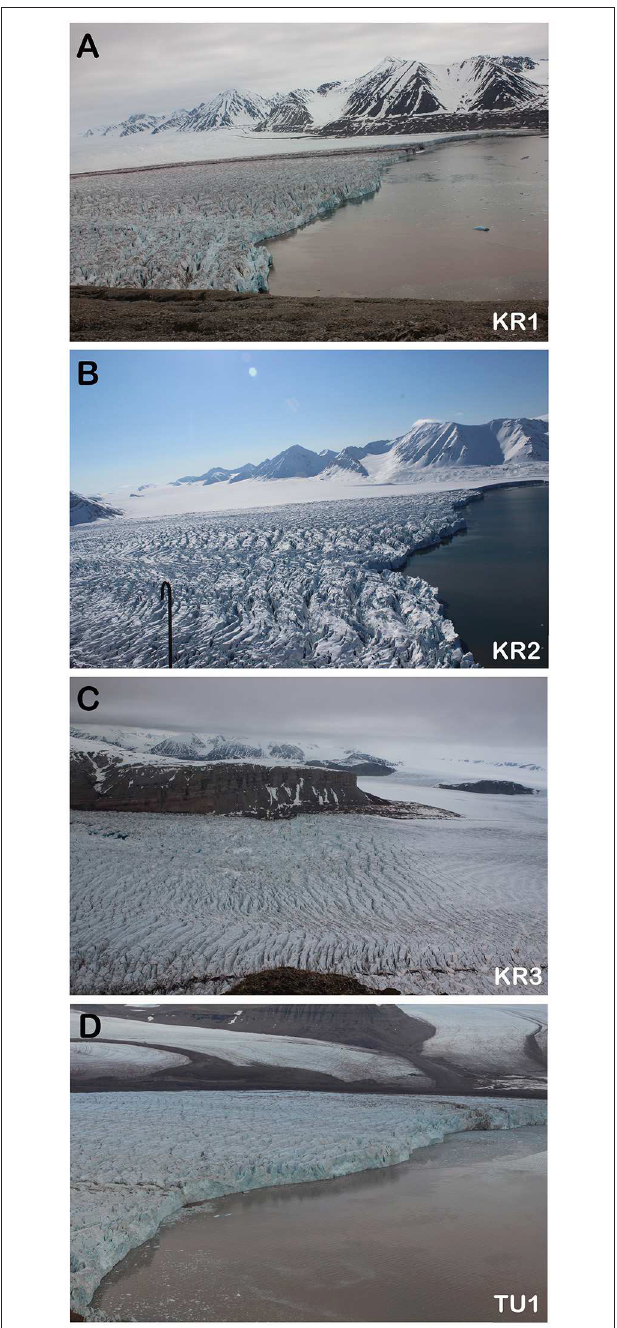
FIGURE 3 | Examples of images taken from each time-lapse camera used in this study. The camera names correspond to those used in the examples presented from PyTrx, and those in Figure 2 . (A) shows the viewpoint from KR1 of the terminus and proglacial area of Kronebreen, which is ideal for examining processes at the ice-ocean interface. (B) shows the viewpoint from KR2 of the terminus and near-terminus area of Kronebreen, which can be used to measure near-terminus glacier dynamics such as glacier surface velocity. (C) shows the viewpoint from KR3 of the upper glacier region of Kronebreen, where supraglacial lakes can be identified and monitored. (D) shows the viewpoint from TU1 of the terminus and proglacial area of Tunabreen, which is optimum for examining terminus